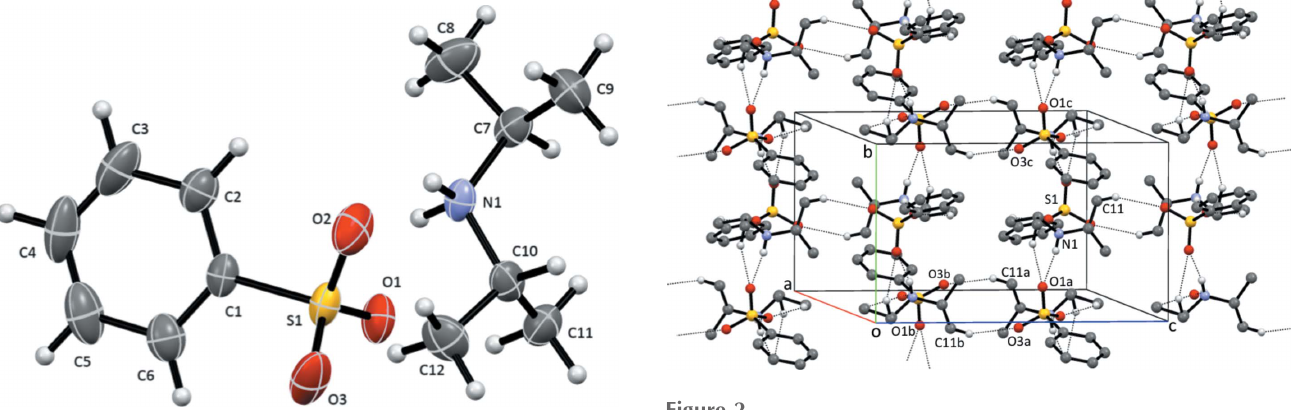
Figure 1 View of the title molecular salt showing anisotropic displacement parameters for non-H atoms drawn at the 30% probability level. Only the major disorder component of the sulfonate group is